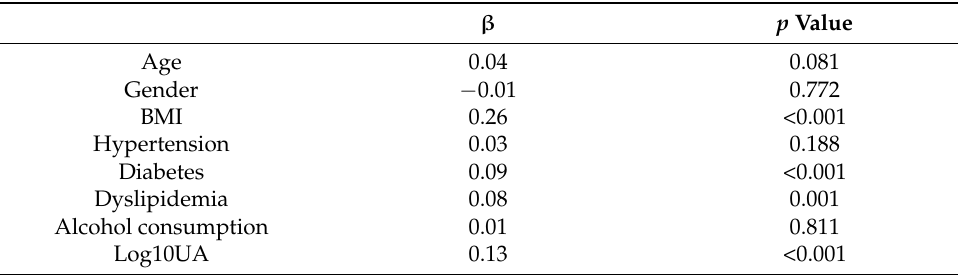
Table 3. Multivariate regression analysis for Log10XOR